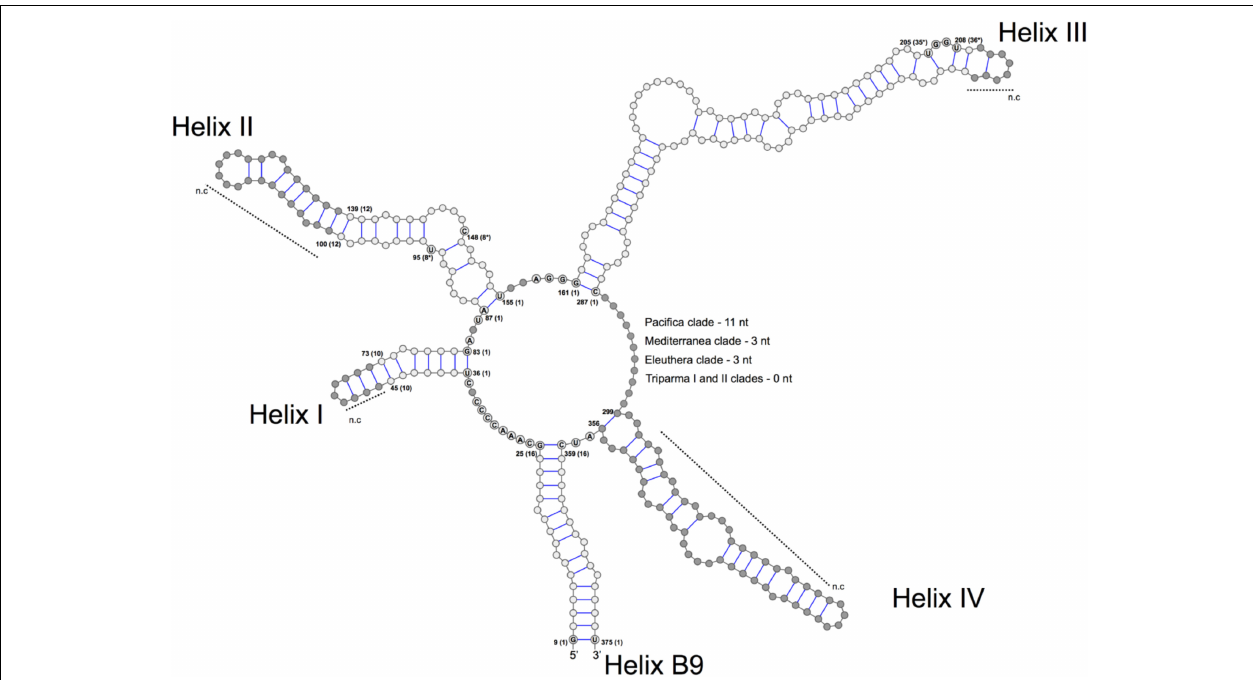
FIGURE 3 | General structure model of the ITS2 molecule of the Triparma clades. The four major helices are labeled as Helix I – Helix IV and the interaction region of 5.8S and 28S rRNA as B9. Numbers refer to the alignment positions and those between brackets to the compared positions in each helix. The nucleotides that are 100% conserved in the helices spacers, hallmarks positions in helices II and III and first two base pairs of the helices are shown. The gray dots represent segments that display length and sequence variation (see Methodology in Supplementary Material